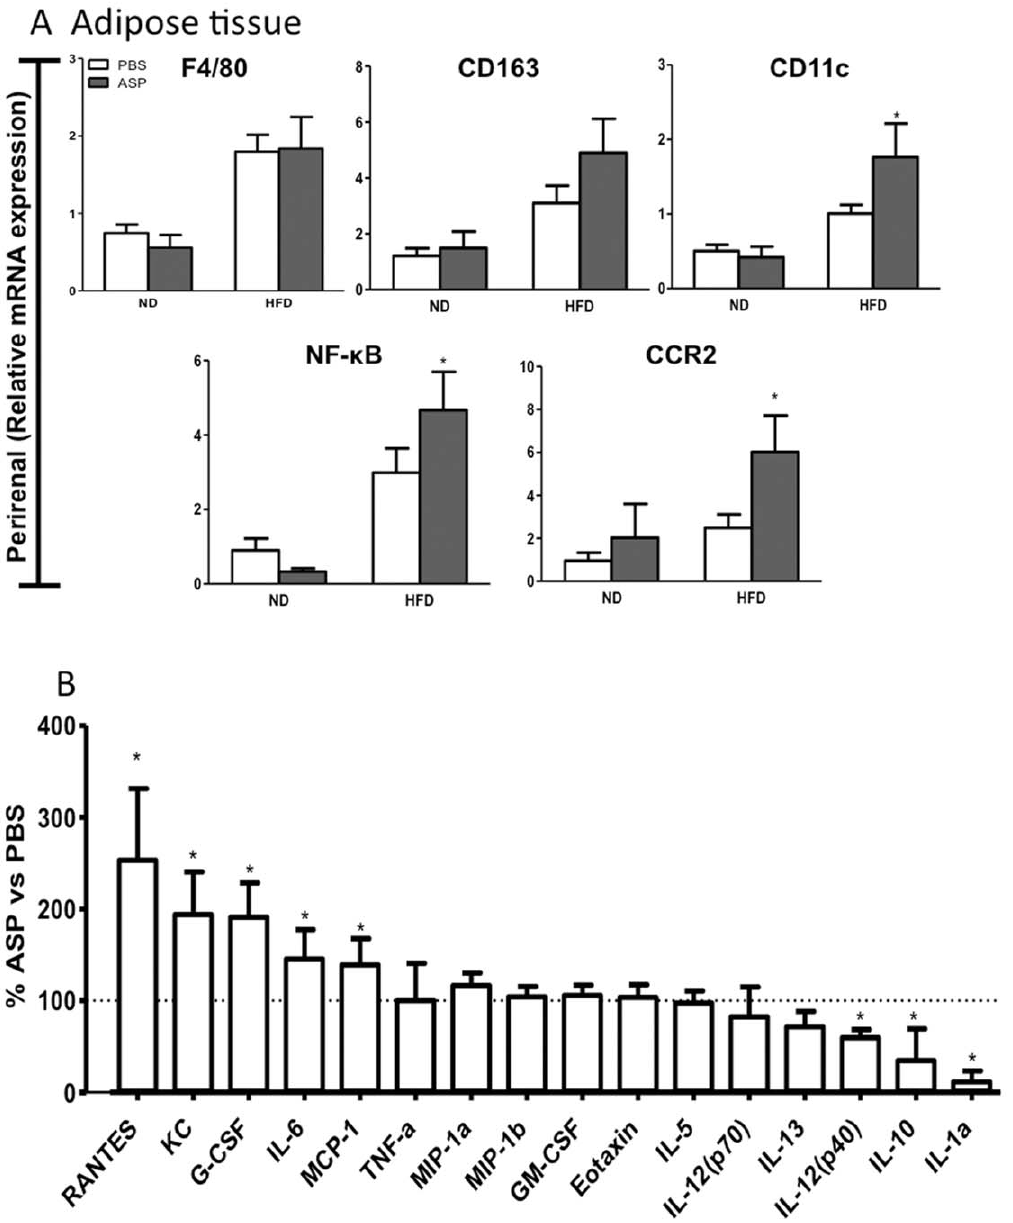
Figure 6. ASP administration induces changes in adipose tissue cytokine secretion and immune-related gene expression. A) Gene expression in perirenal adipose tissue in C3KO 6 ASP in ND and HFD mice. B) Cytokine secretion in ex vivo adipose tissue from C3KO or C3KO + ASP mice fed on ND and HFD incubated for 24 hours (n=6–9). Results are presented as average 6 SEM (n=5–8), where *p , 0.05, **p , 0.01 and ***p ,